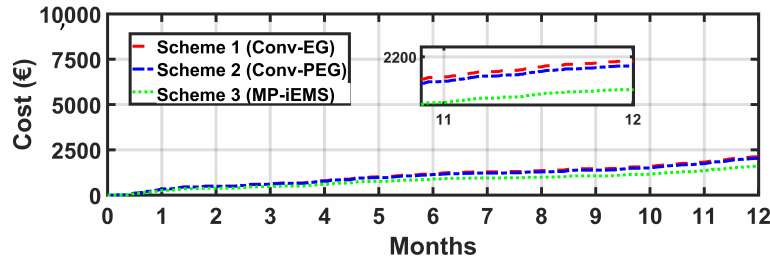
Figure 16. Total EV storage utilization cost.